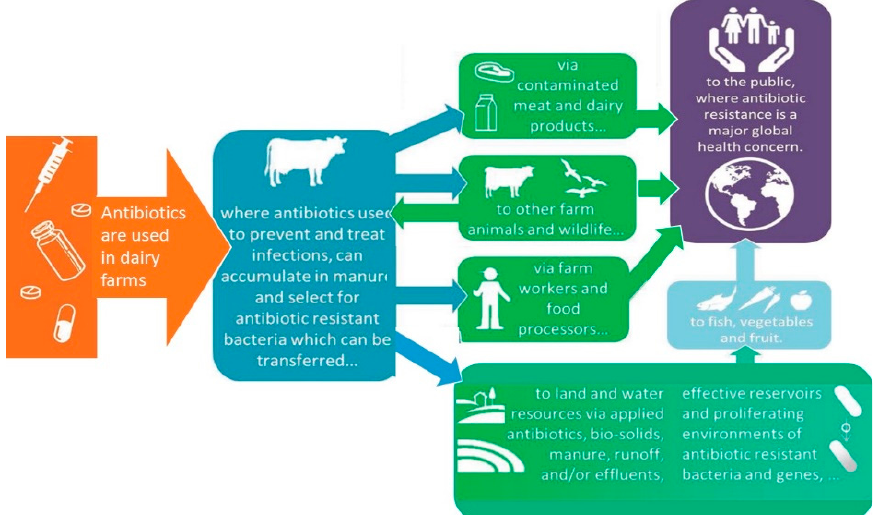
Figure 3. Potential routes of antibiotics and antibiotic resistance transmission, which have their origin in the use of antibiotics in the treatment of farm animals and can reach humans and the environment. (Adapted from [141] with the permission of Elsevier).